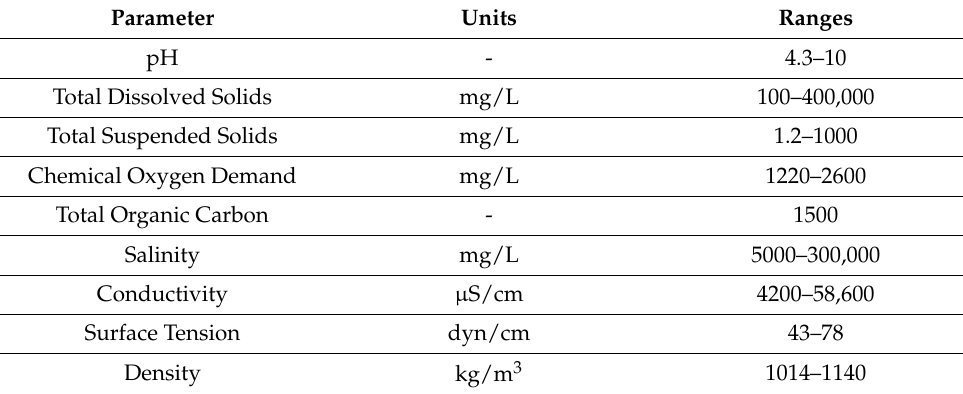
Table 1. Composition of produced water